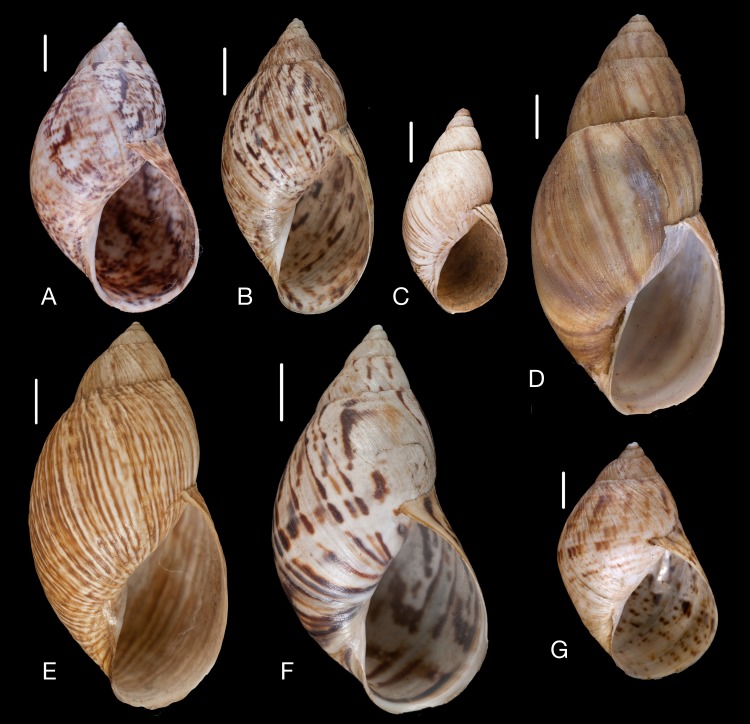
Material collected by the CCP.(A–G) Bothriembryontidae. Plectostylus broderipii (Sowerby I in Broderip & Sowerby I, 1832), MNCN 15.05/13467, (A) ventral view; Plectostylus coquimbensis (Broderip in Broderip & Sowerby I, 1832), MNCN 15.05/13670, (B) ventral view; Plectostylus cf. reflexus (Pfeiffer, 1842), MNCN 15.05/13886, (C) ventral view; Plectostylus chilensis (Lesson in Lesson, Garnot & Guérin-Méneville, 1830), MNCN 15.05/13384, (D) ventral view; Plectostylus peruvianus (Bruguière, 1792), MNCN 15.05/13466, (E) ventral view; Plectostylus punctulifer (Sowerby I in Sowerby I & II, 1833), MNCN 15.05/76237, (F) ventral view; Plectostylus coturnix (Sowerby I in Broderip & Sowerby I, 1832), MNCN 15.05/13678, (G) ventral view. Scale line 5 mm.